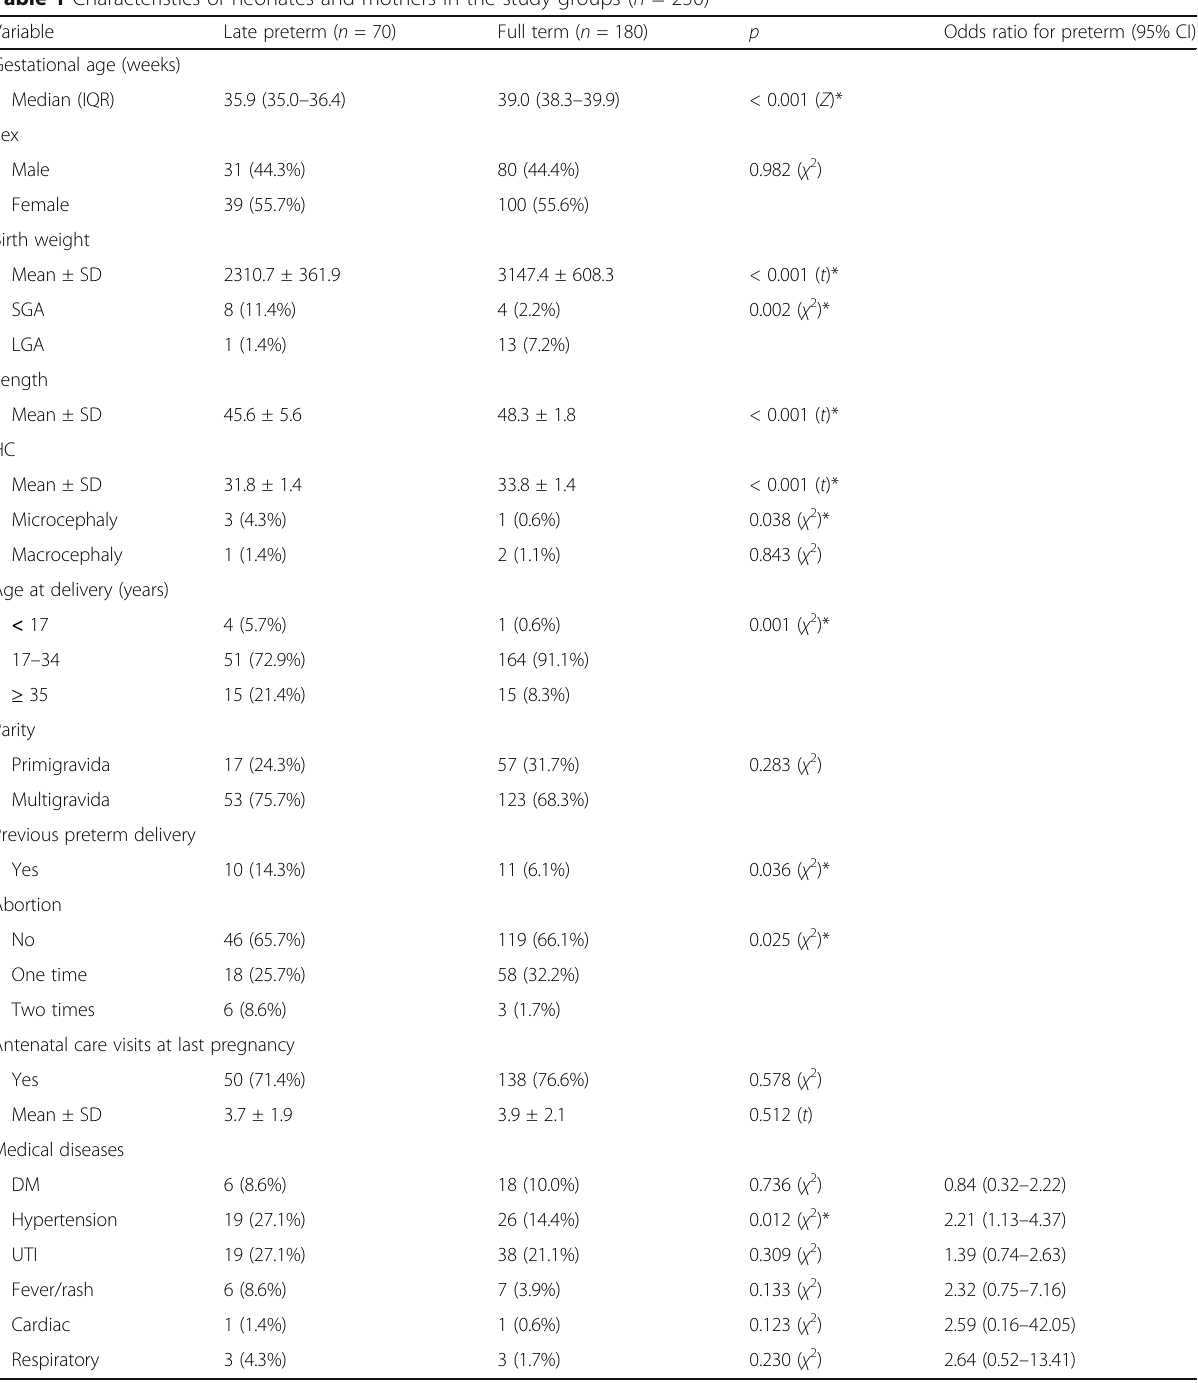
Table 1 Characteristics of neonates and mothers in the study groups ( n = 250) Variable Late preterm ( n =